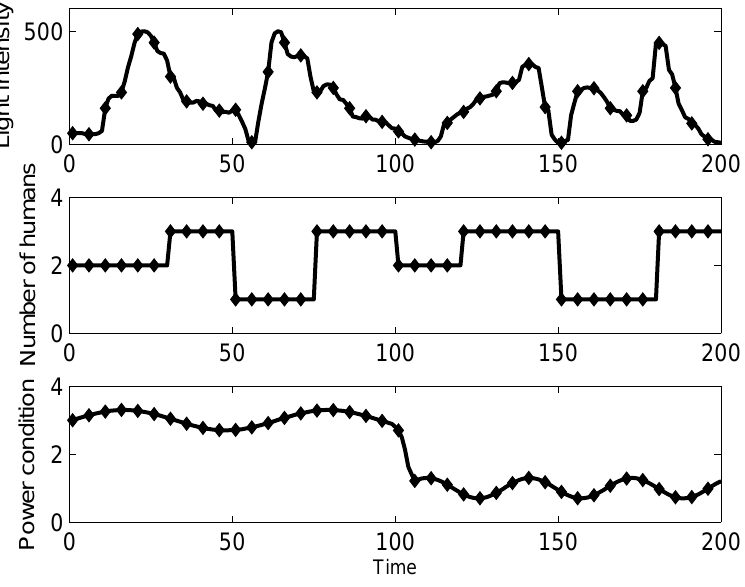
Figure 16. Environment, user and system information: ( first row ) light intensity; ( second row ) number of humans; ( third row ) power